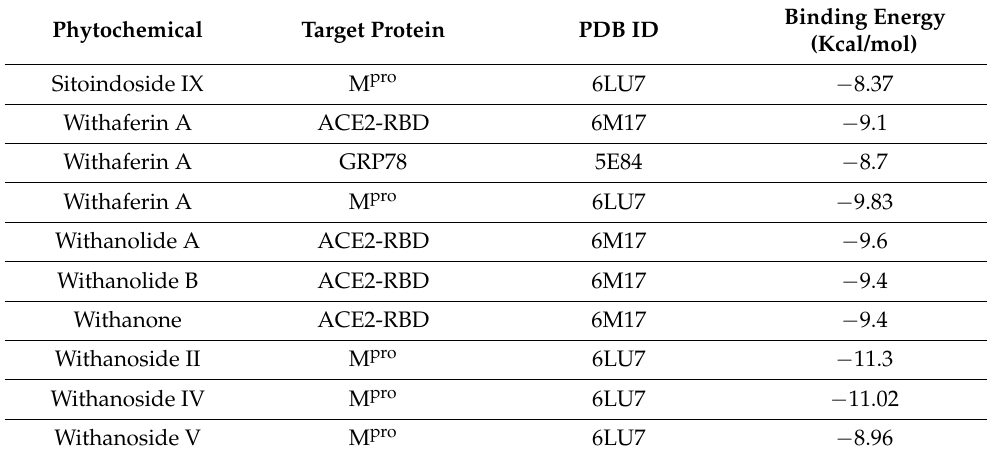
Table 3. Binding energy of WS phytochemicals against protein targets of SARS-CoV-2 and its host cells. Phytochemical Target Protein PDB ID